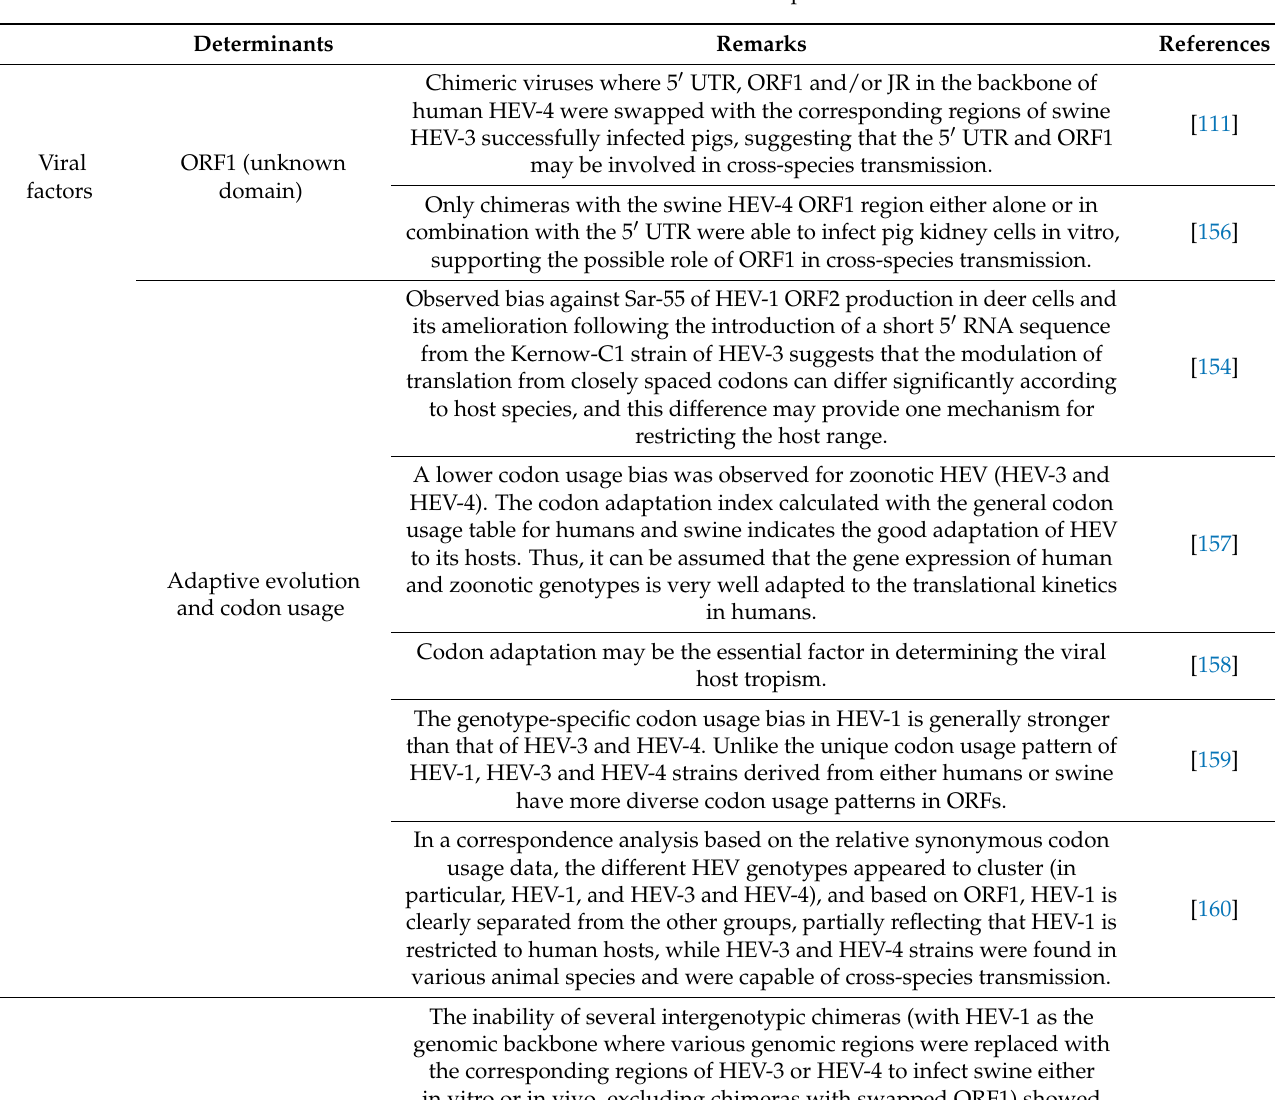
Table 2. Possible viral and host factors involved in cross-species transmission of